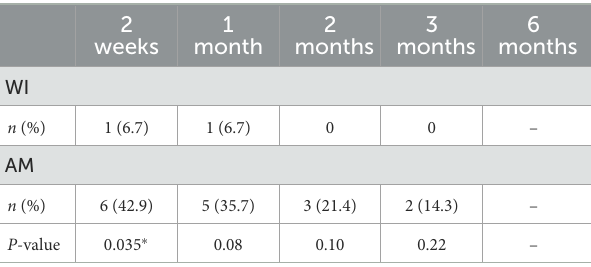
TABLE 5 Outcome measures regarding the occurrence of pillar